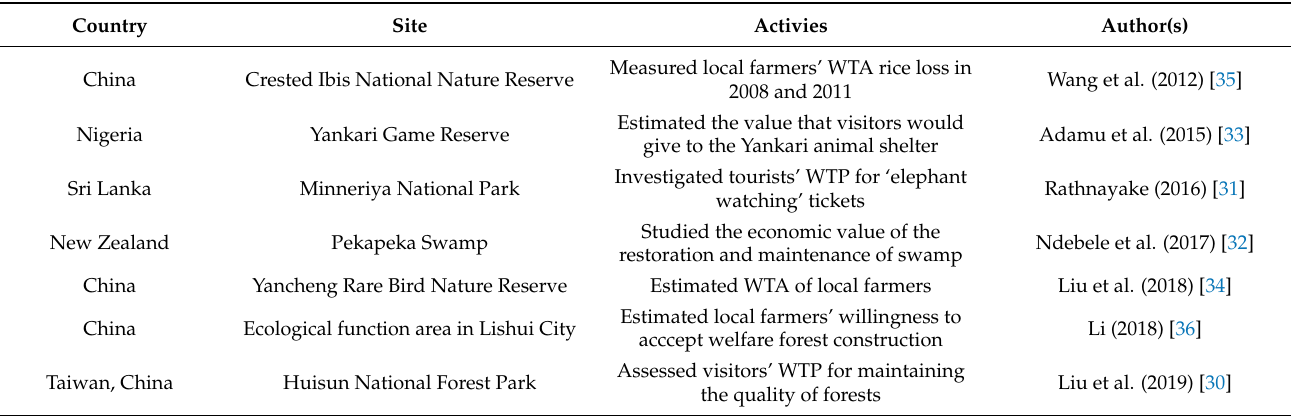
Table 1. Contingent valuation method (CVM)